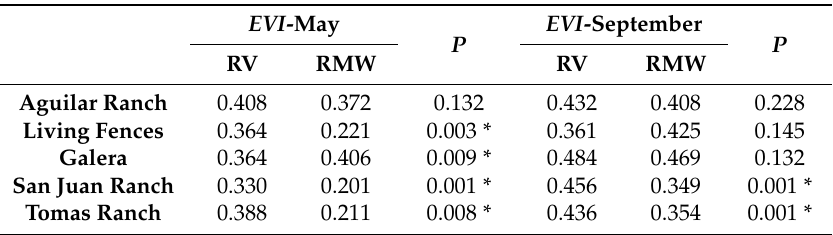
Table 9. EVI averages for May and September for sites with Riparian Vegetation (RV) and Riparian Mesquite Woodland (RMW). Significance level ( P ). Values with * show a significant difference. EVI -May